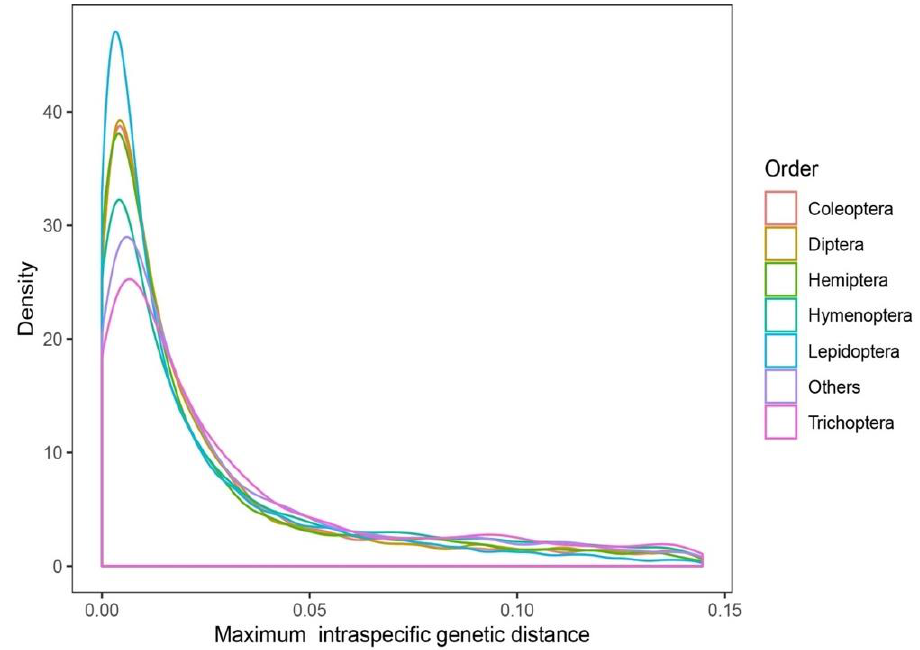
Figure 1. Frequency density of maximal intraspecific genetic distances of different orders. If the thresholds of 1%, 2%, 2.2%, and 3% were used in the clustering analysis, the 64,414 species could be divided into 113,055, 90,408, 87,875, and 81,864 clusters, respectively. Among them, 26,943 (23.83%), 17,483 (19.34%), 16,178 (18.41%), and 12,854 (15.70%)